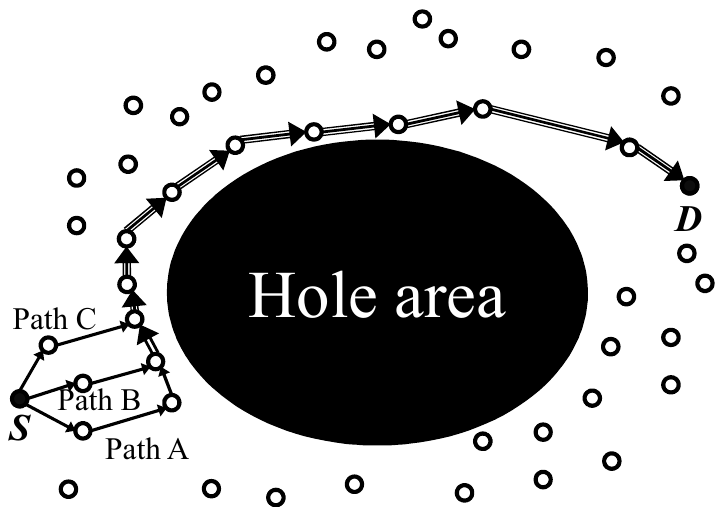
Figure 3. The overlapping problem near the hole area during multipath